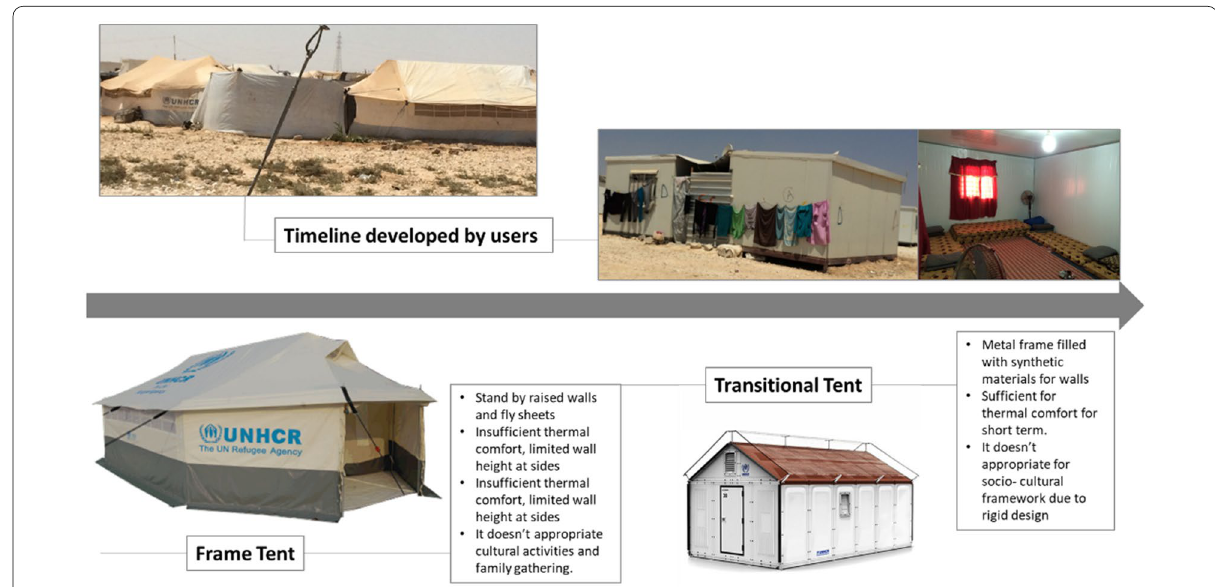
Fig. 2 Humanitarian organized shelters and user adapted